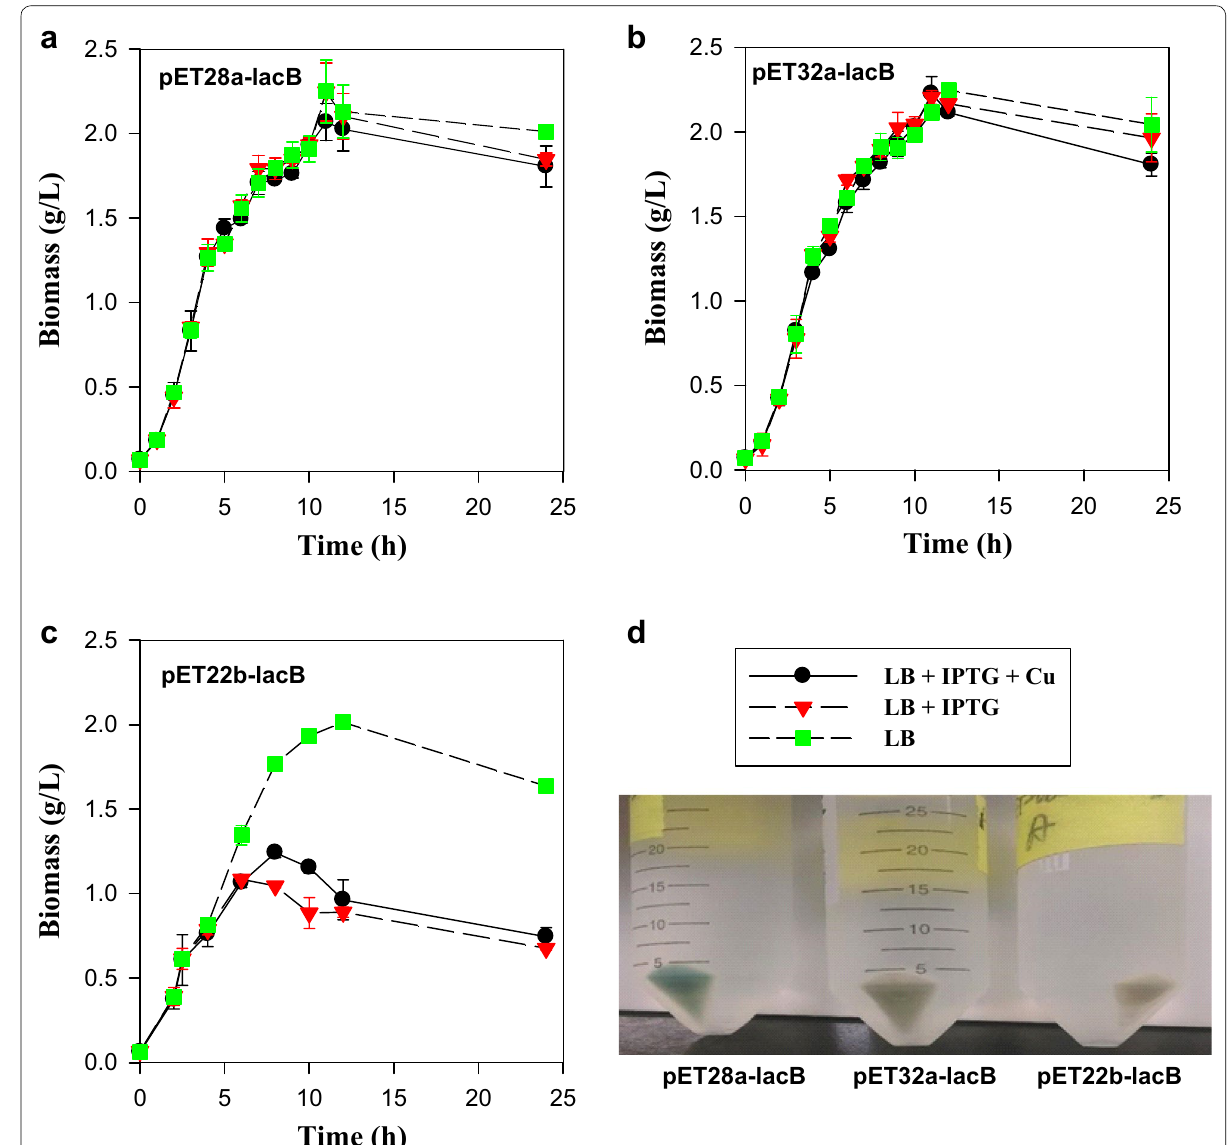
Fig. 2 Time course of biomass growth, using different expression vectors and conditions. Circles represent LB LB IPTG, and squares represent LB. a pET28a‑lacB, b pET32a‑lacB, c pET22b‑lacB, and d cell pellets harvested after +